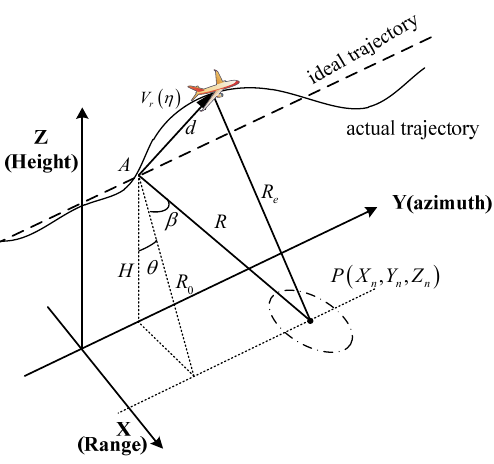
Figure 1. Geometry of the airborne SAR with motion error.